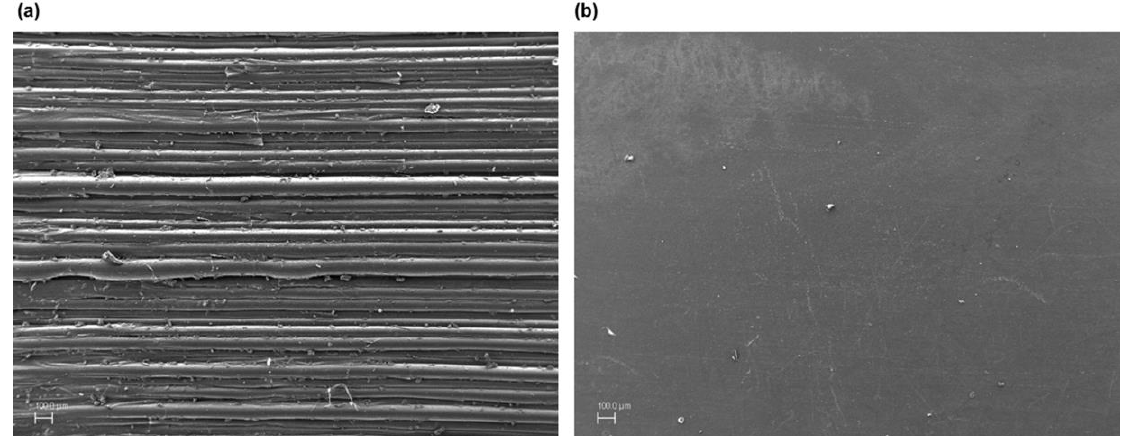
Figure 5. Polycarbonate component manufactured with 3D FDM printing without chemical treatment 250 × ( a ) and with dichloromethane chemical treatment 250 × ( b ).